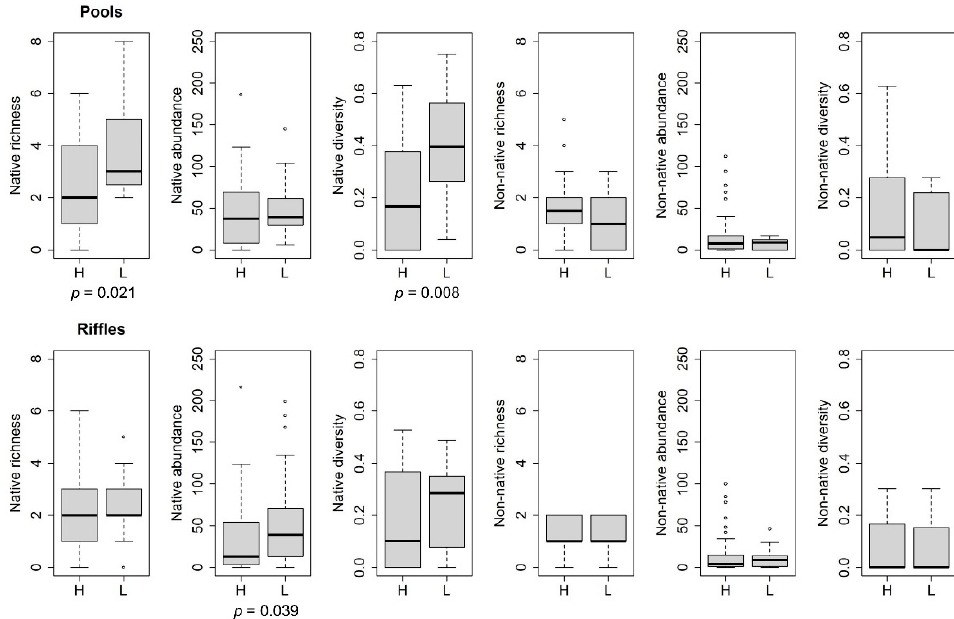
Figure 3. Diversity measures of native and non-native fish communities and the presence of statis- tically significant differences according to fragmentation level (L: Low; H: High) in riffle and pool habitats. Richness, S; diversity, H´; abundance, N. Native fish species, Percichthys trucha , Basilichthys microlepidotus , O. mauleanum , Gal- axias maculatus, and Geotria australis, were associated with nektonic habits, migratory be- havior, and/or a broad range of environmental conditions, suggesting high dispersion ca- pacities (Figure 4). Furthermore, P. trucha , B. microlepidotus , O. mauleanum, and G. australis were characterized by large body length (>12 cm), whereas G. maculatus by the broadest range of environmental conditions (Figure 4). Percilia gillissi , P. irwini , Cheirodon galusdae, and C. pisciculus that inhabited both pools and riffles were associated with resident be- havior and small body size. Finally, both large ( N. inermis , D. incognitus , D. nahuelbutaensis ) and small ( Trichomycterus areolatus and Bullockia maldonadoi ) body-sized native catfish were associated with benthic habits (Figure 4).